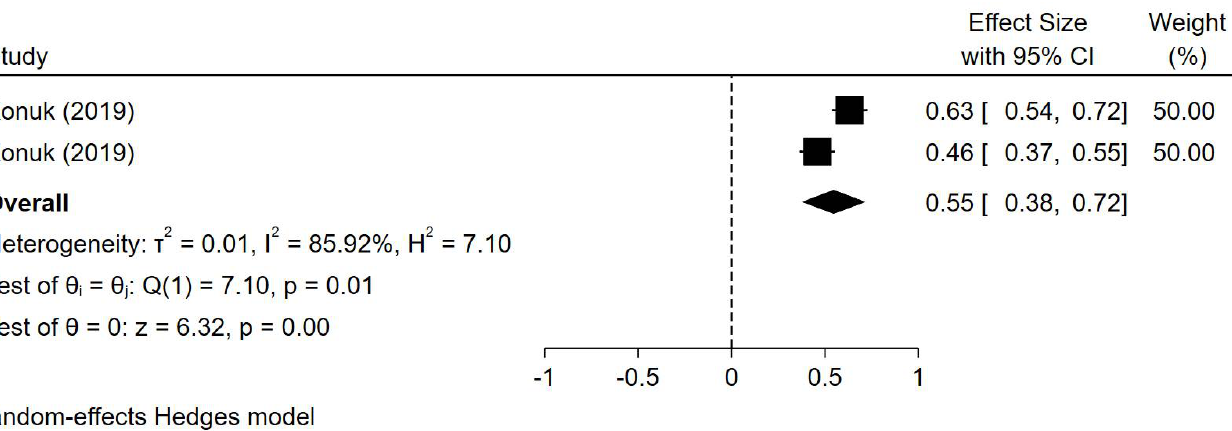
Figure 7. Meta-analysis of the association between ethical concern and consumer purchase behavior.